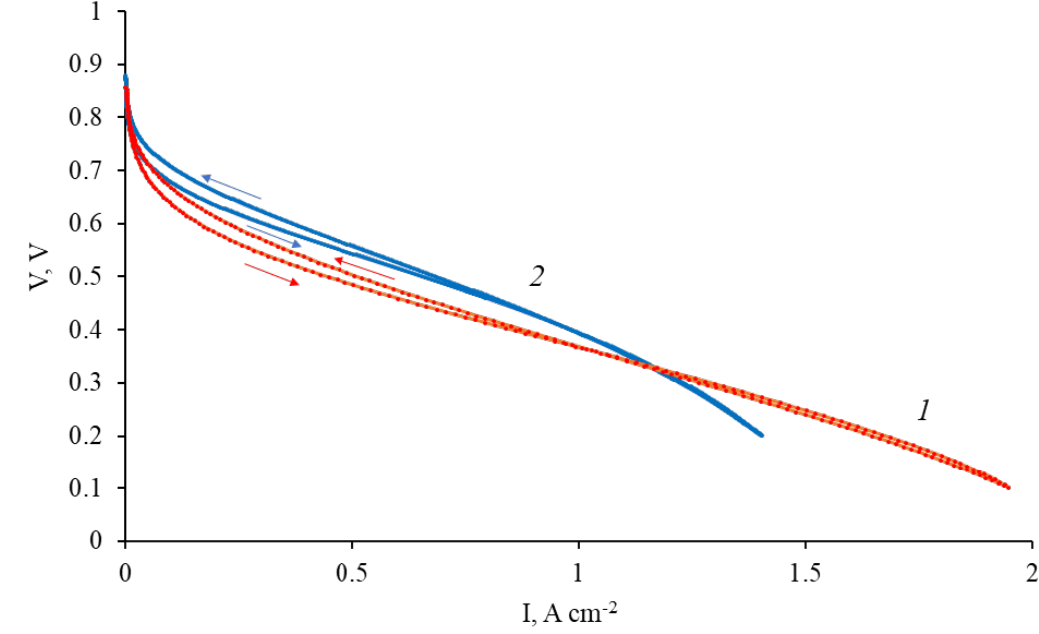
Figure 9. Polarization curves for the Pt/2 cathode (1) and commercial Celtec ® P1000 cathode (2).